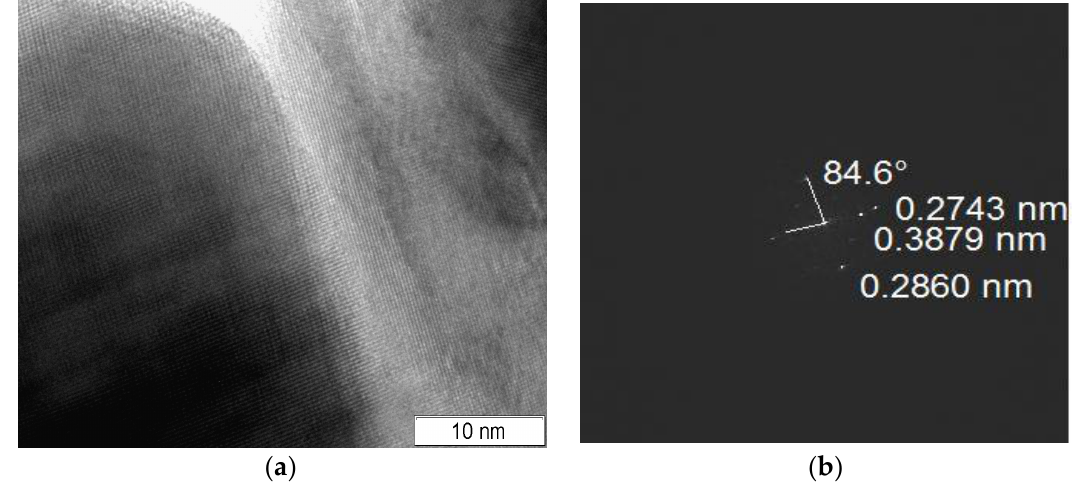
Figure 3. Interphase boundary ( a ) and its Fourier transform image ( b ). Sample 5.